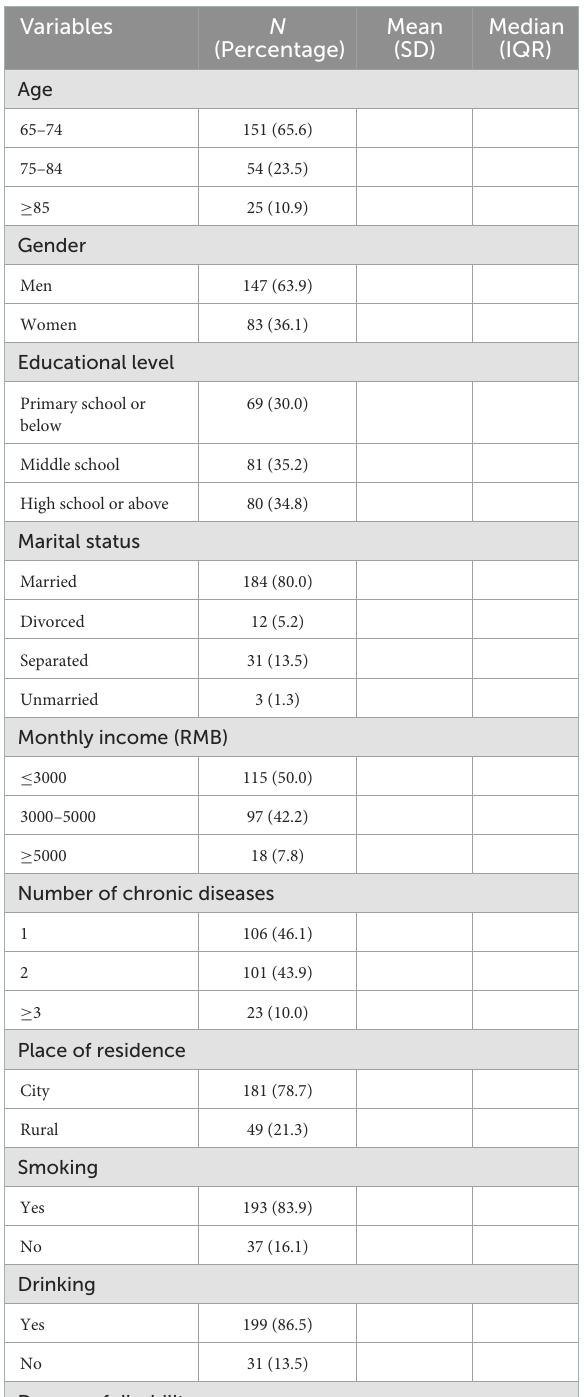
TABLE 1 Characteristics of the